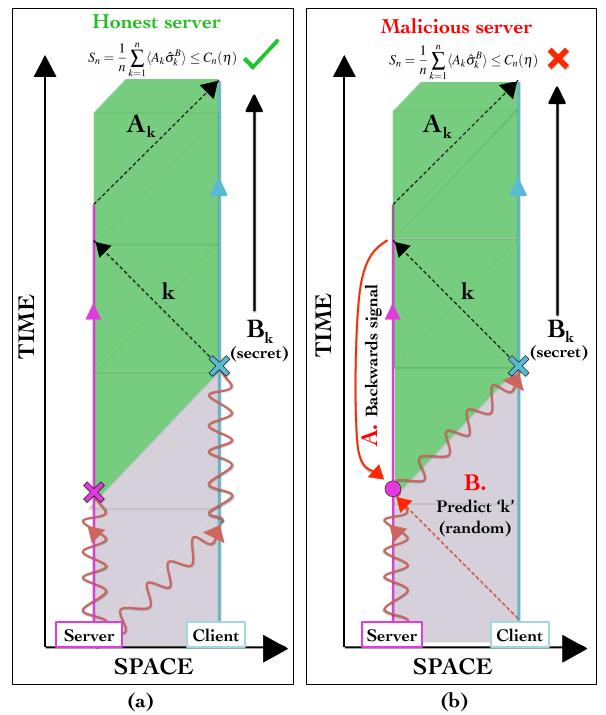
Fig. 5. Spacetime diagrams for mining via PoE in the case of an honest and dishonest quantum server. Red squiggles represent photonic qubits, which in (a) are entangled. Mea- surements are denoted using pink (quantum server) and blue (client) crosses. Classical data is communicated with dashed lines in accordance with the mining protocol (main text). Se- cret data is communicated with solid lines. Purple shading represents times during which the quantum server is able to transmit a photonic qubit, within the limitations of the proto- col, to the client. Green shading represents times during which the server may announce measurement outcomes A k (recorded by the client after they perform their measurement). In (b), so-called cheating strategies are considered, which permit false announcements, fal- sified timestamps, and fabricated qubit encodings (pink disk), which a server might utilise in an attempt to fabricate entanglement. Successful attempts require violating backwards non-signalling (A) or measurement independence (B). See main text for